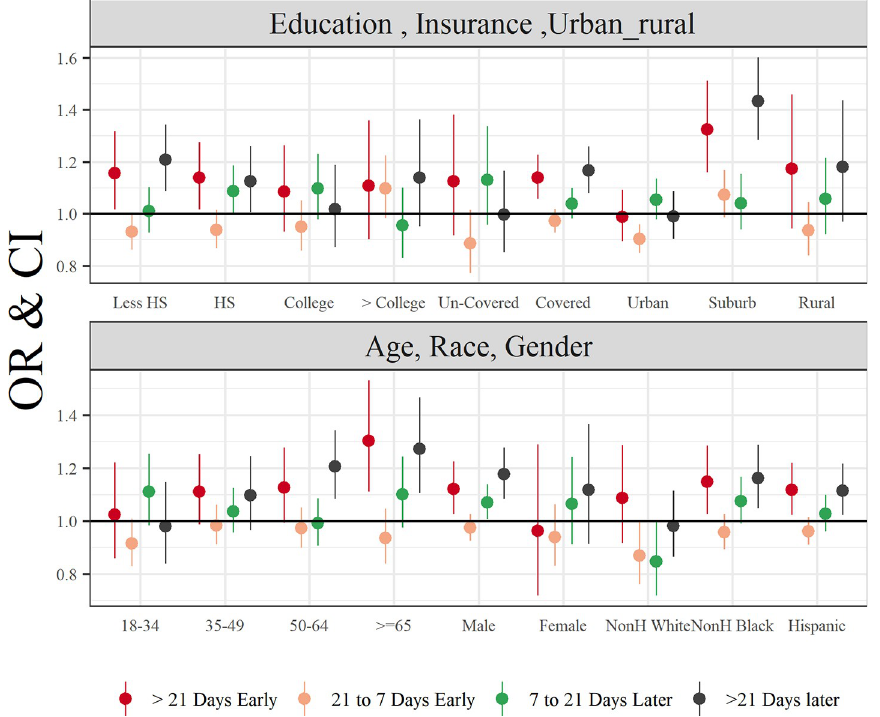
Fig 1. Odds Ratios and 95% CIs for changes in plant phenology and prevalence of hay fever, stratified by demographic characteristics, urban/rural status, and insurance coverage.